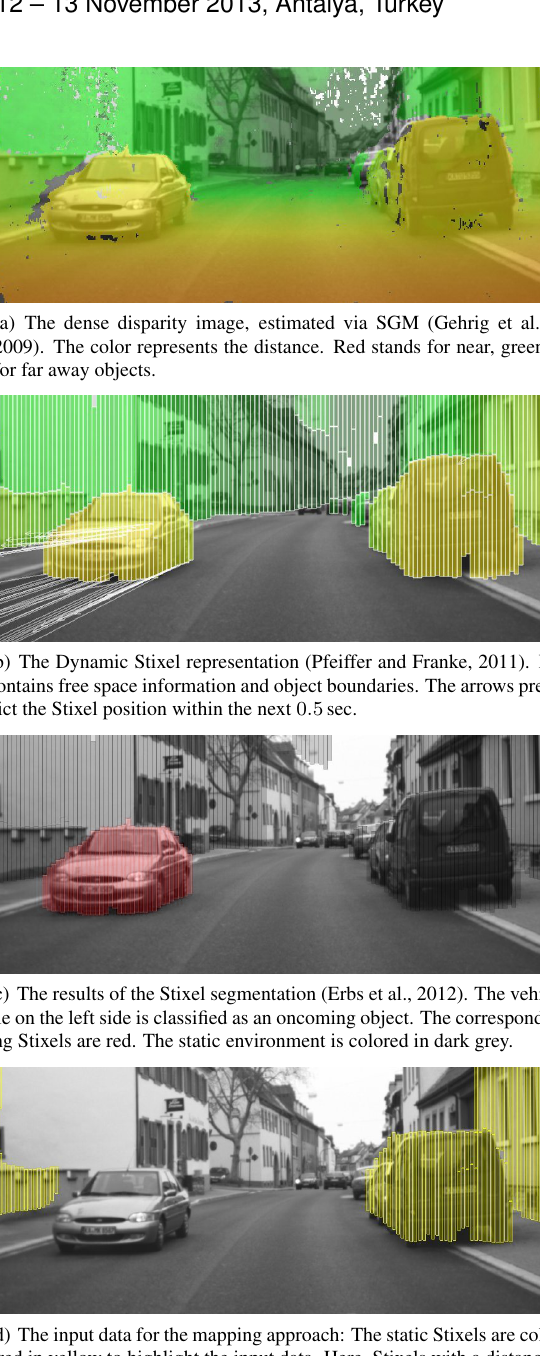
Figure 2: Pipeline of the generation of the input data. of a cell is given by the Cartesian information of the center point ( X j and Z j ) and the belief mass function : m j = [ X j Z j m ∗